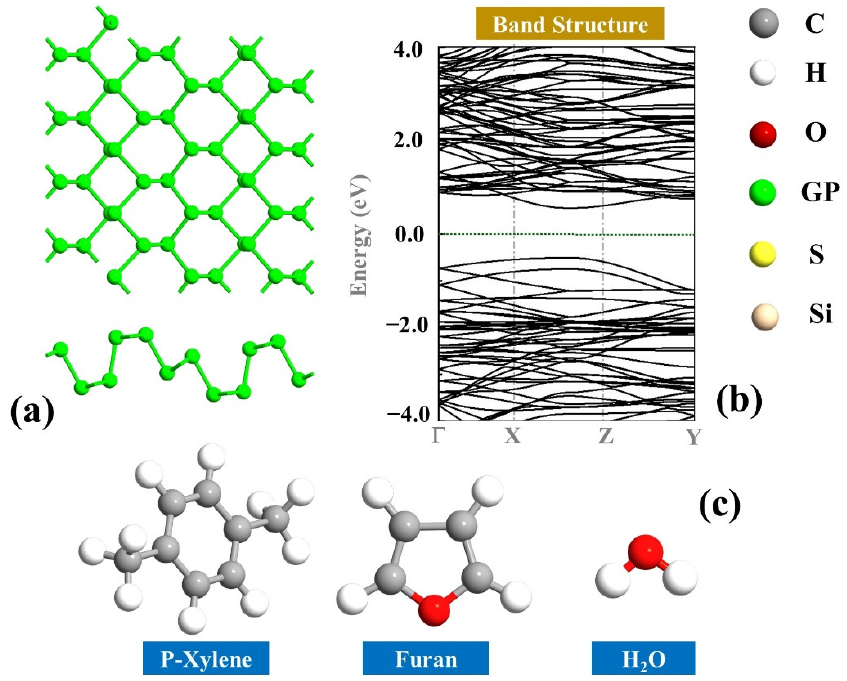
Figure 1. Illustration of ( a ) monolayer GP (top and side views), ( b ) band structure of the GP, and ( c ) structures of p-Xylene (C 8 H 10 ), furan, and H 2 O molecules.